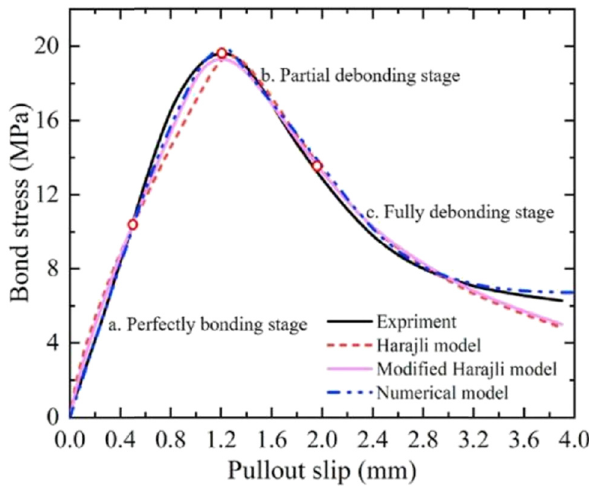
Figure 9: Relationship between slip and stress of reinforce - ment [ 77 ]